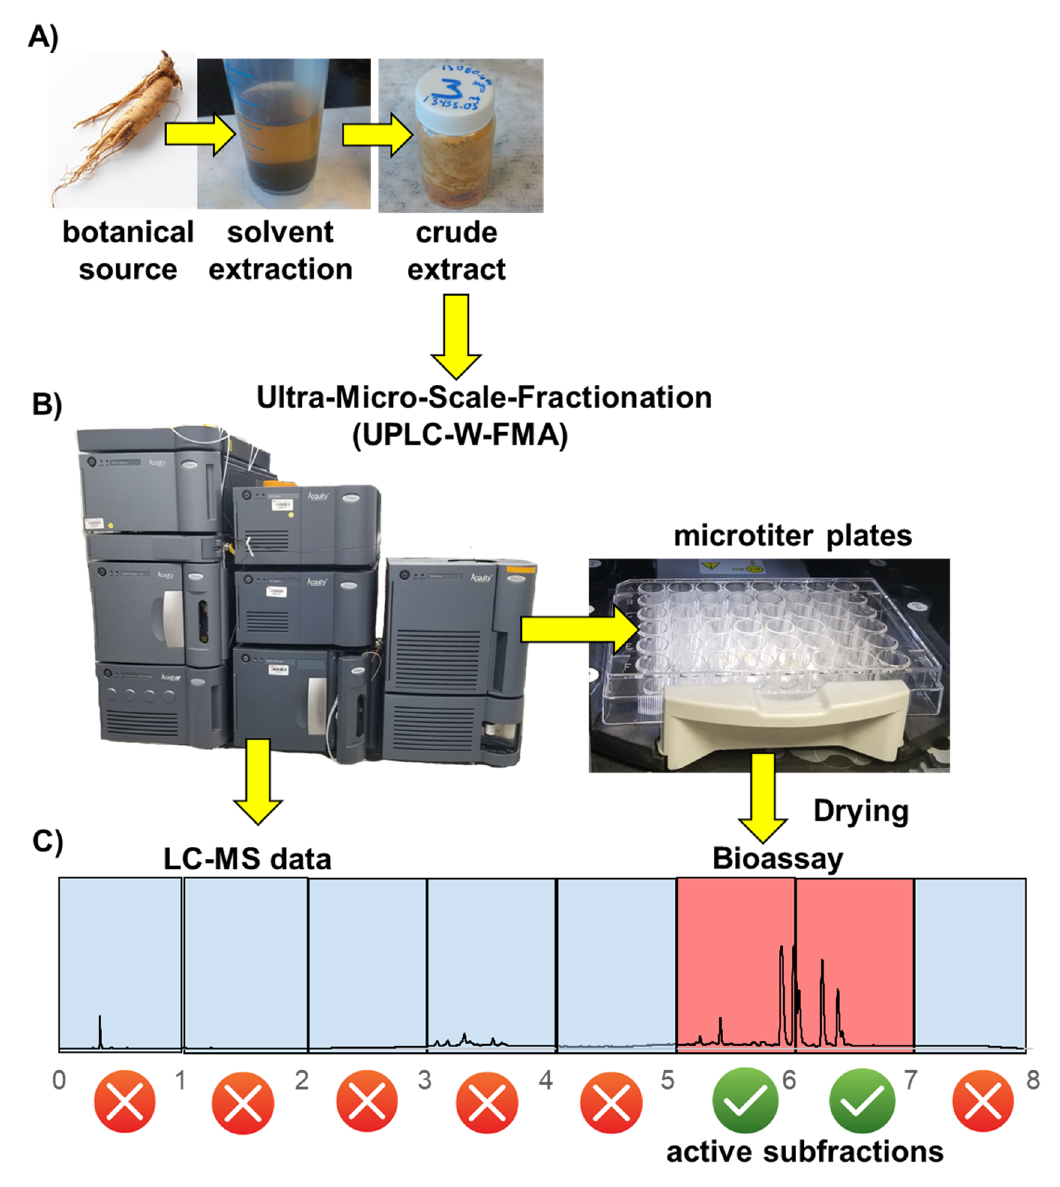
Figure 2. Ultra-micro-scale-fractionation (UMSF). ( A ) Crude extracts are prepared; ( B ) crude extracts are simultaneously analyzed and fractionated into simpler mixtures using high-resolution ultra-performance liquid chromatography (UPLC) separations. Individual fractions are collected into wells of microtiter plates for later bioassay; ( C ) chemical characteristics of active fractions are queried from existent liquid chromatography mass spectrometry (LC-MS) data, to identify and triage lead compounds. Most bioactives discovery programs already have dedicated UPLC / UHPLC analytical chemistry platforms in place for both quantitative and qualitative analyses, be it the untargeted profiling of crude extracts or fractions prepared thereof, or purity checks for isolated peaks, however, most groups still rely on ine ffi cient FC or SPE to conduct their initial fractionation. Adaption of the UMSF technique can be achieved through a modest investment into a fraction collector while boosting throughput and reducing consumable